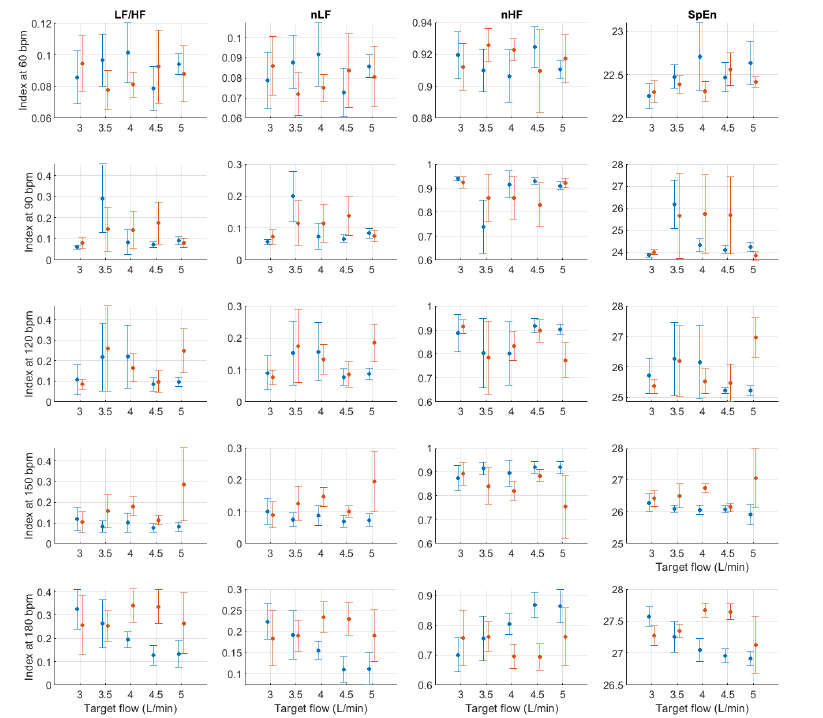
Figure A9. Mean and standard deviation of relative frequency-domain indices extracted from pulse rate variability under different stroke rates (SR) and target flows (TF, TF above 2.5 L/min) conditions, and measured from the radial (blue) and deep palmar arch (orange) phantoms.